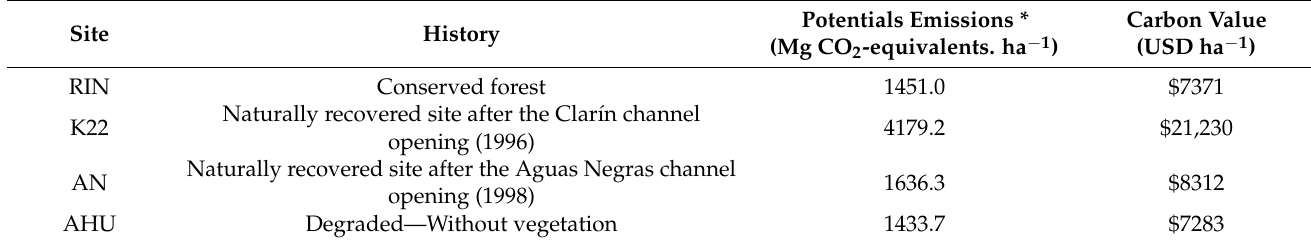
Table 7. Carbon stocks expressed as potential CO 2 emissions (Mg CO 2 -equivalents. ha − 1 ) in study sites and their economic value. Data are based on aboveground biomass and soil up to 2 m